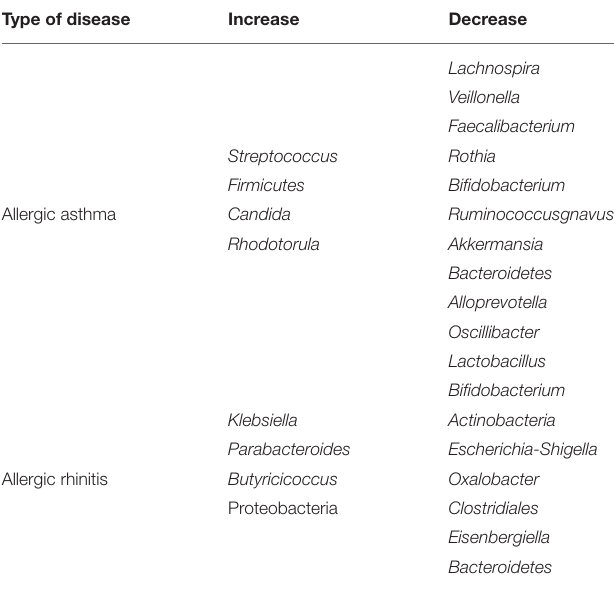
TABLE 1 | Changes of the gut microbiota in allergic asthma and allergic